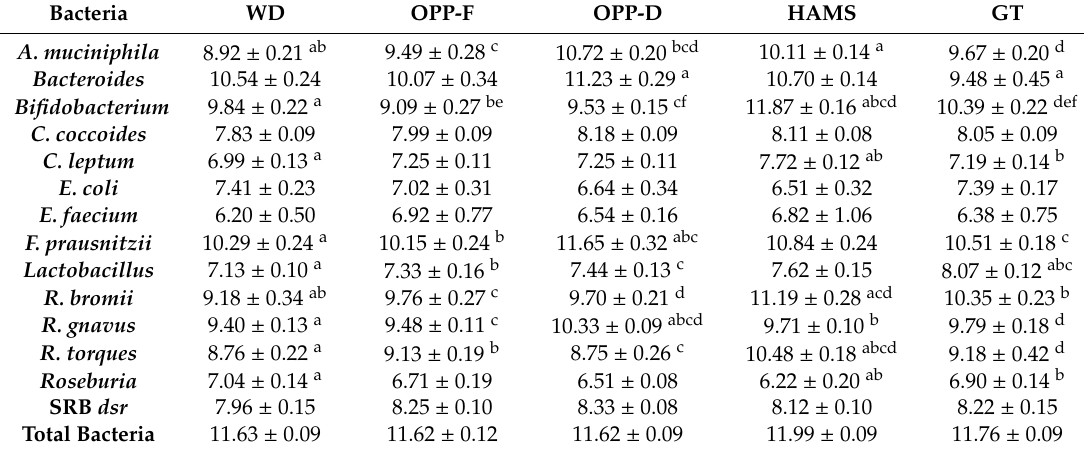
Table 5. E ff ects of dietary treatment on numbers of caecal bacteria 1 .